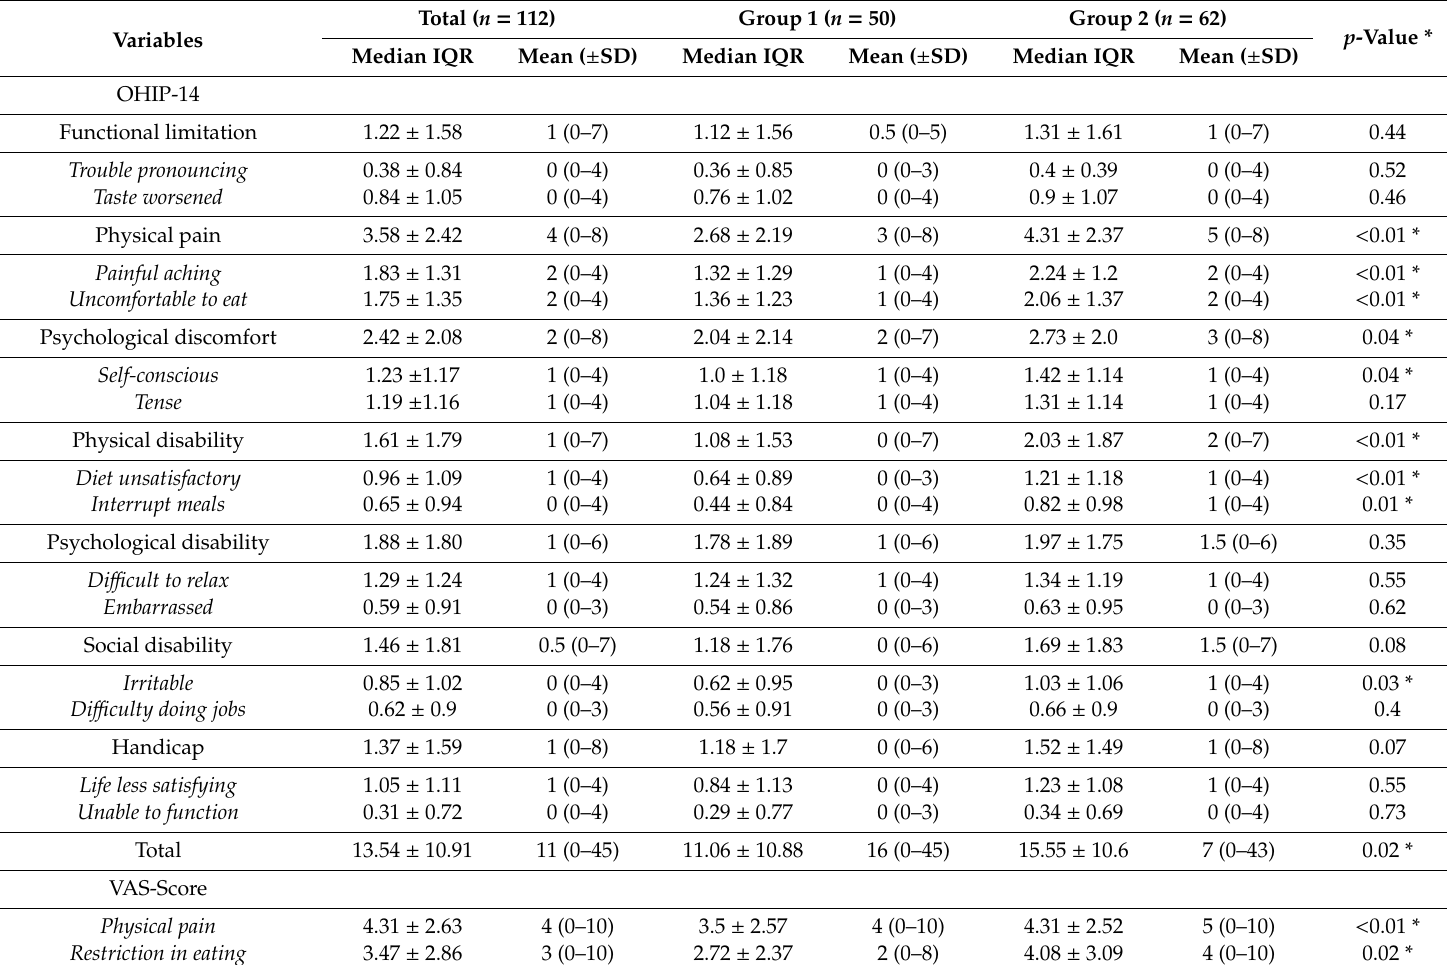
Table 2. Analysis of responses to Oral Health Impact Profile (OHIP-14) domains and VAS according to the clinical form of disease.